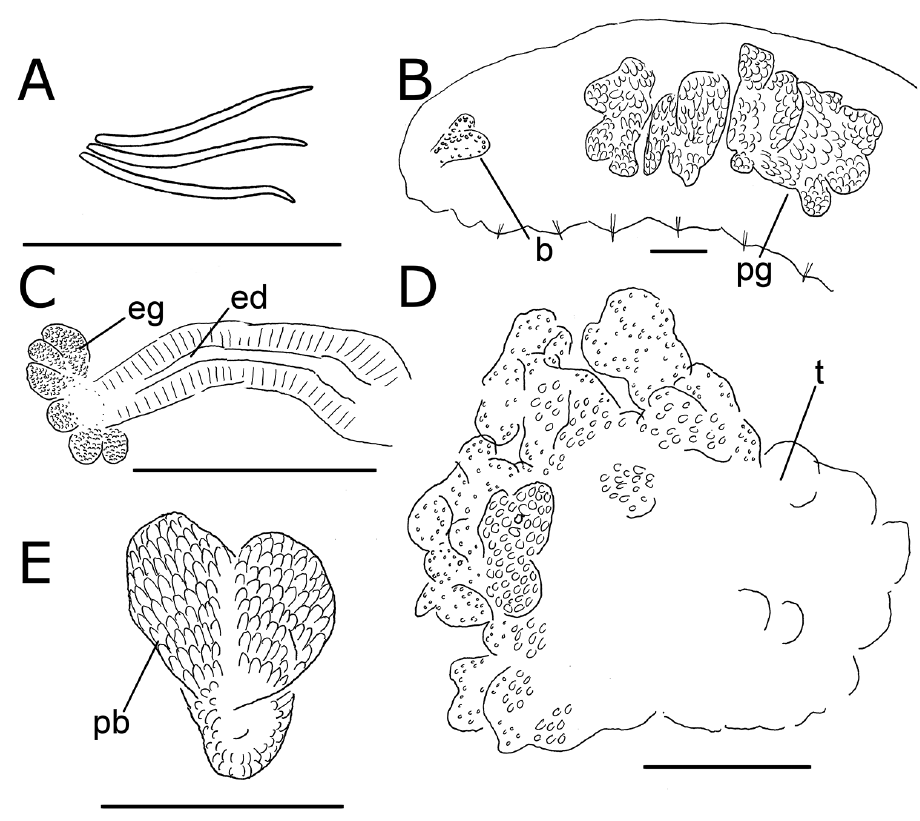
Figure 22. Lumbricillus sp. H. A Chaetal bundle B Anterior body C Spermatheca D Testis E Penial bulb. Abbreviations under general notes. Scale bars: 100